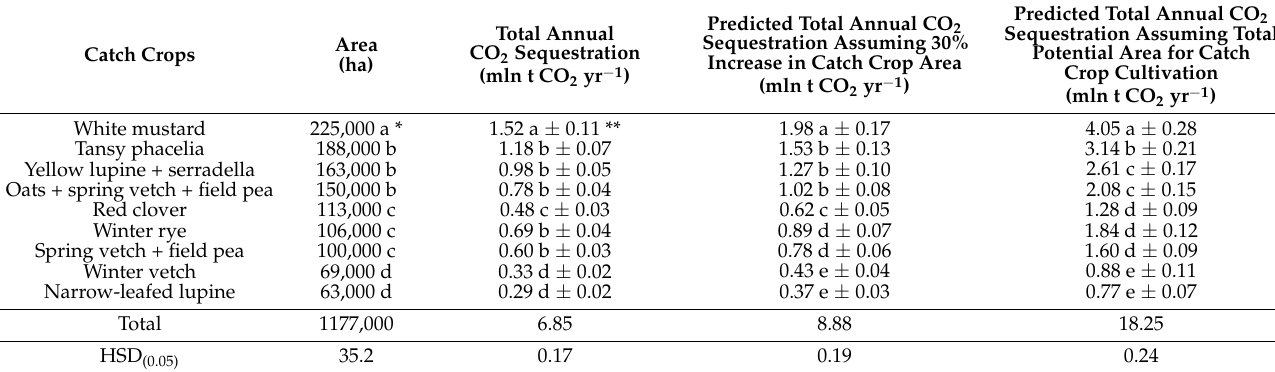
Table 2. Total annual sequestration of CO 2 by catch crops cultivated in